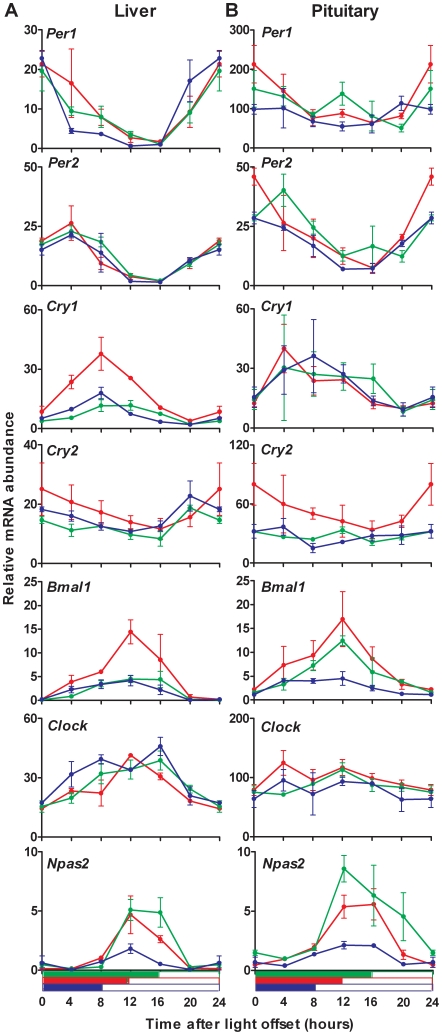
The circadian oscillator in liver, but not in pituitary, was phase-locked to light offset.Data presented in Figure 1 were re-plotted, with the time origin defined as light offset. Note the better alignment of the various gene expression profiles in the liver (A) than the pituitary (B). Values obtained at lights off have been plotted twice (t = 0 and t = 24) for better visualization. The symbol and color legend is as described in Figure 1.